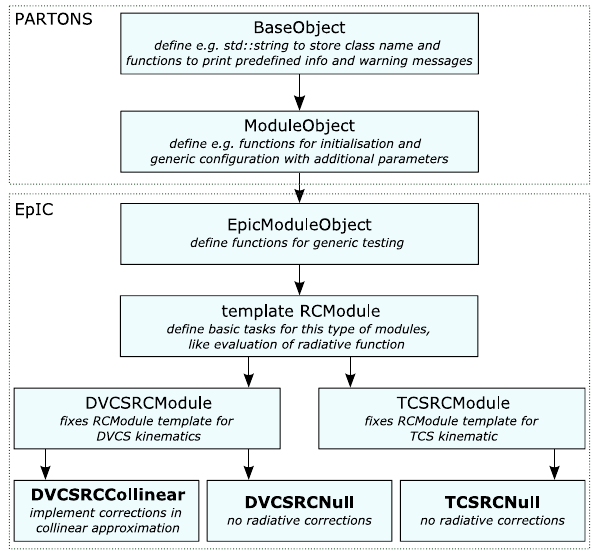
Fig. 3 Inheritance tree of modules used for the implementation of radiative corrections. Each box represents a single C++ class. Two first classes are the part of PARTONS library, the rest are the part of EpIC project. Classes acting as modules to be used by users are indicated by boldface